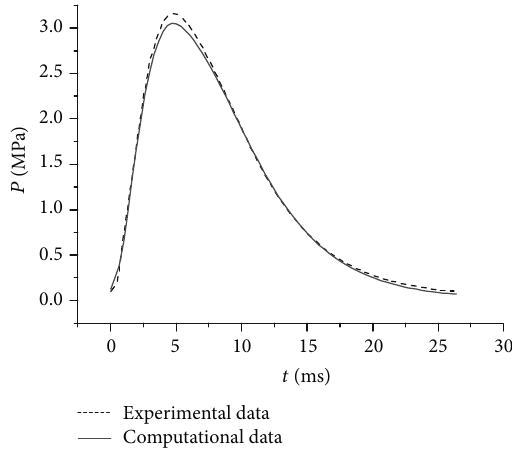
Figure 3: Pressure data from experiment and numerical